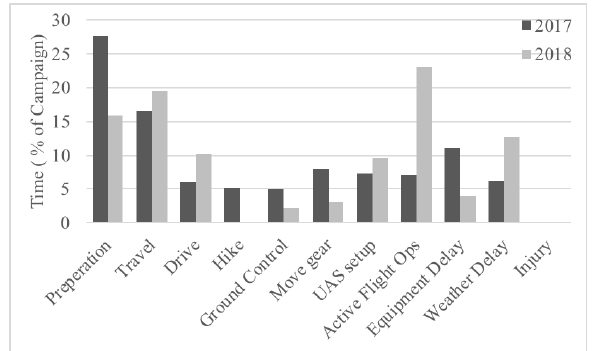
Figure 3. Time spent in each category as a percentage of the total campaign time.